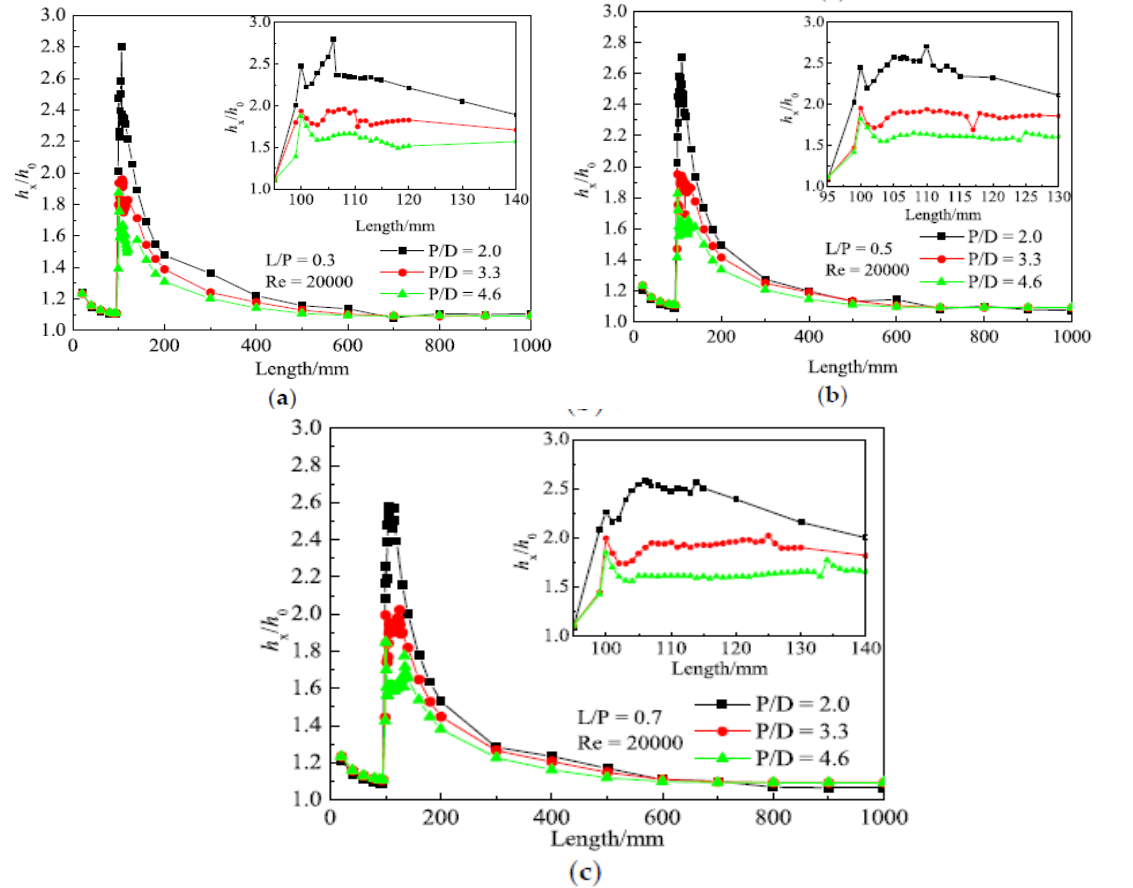
Figure 8: Relationship between heat transfer coefficient and twist ratio (P/D) along the tube: (a) Length ratio, L/P =